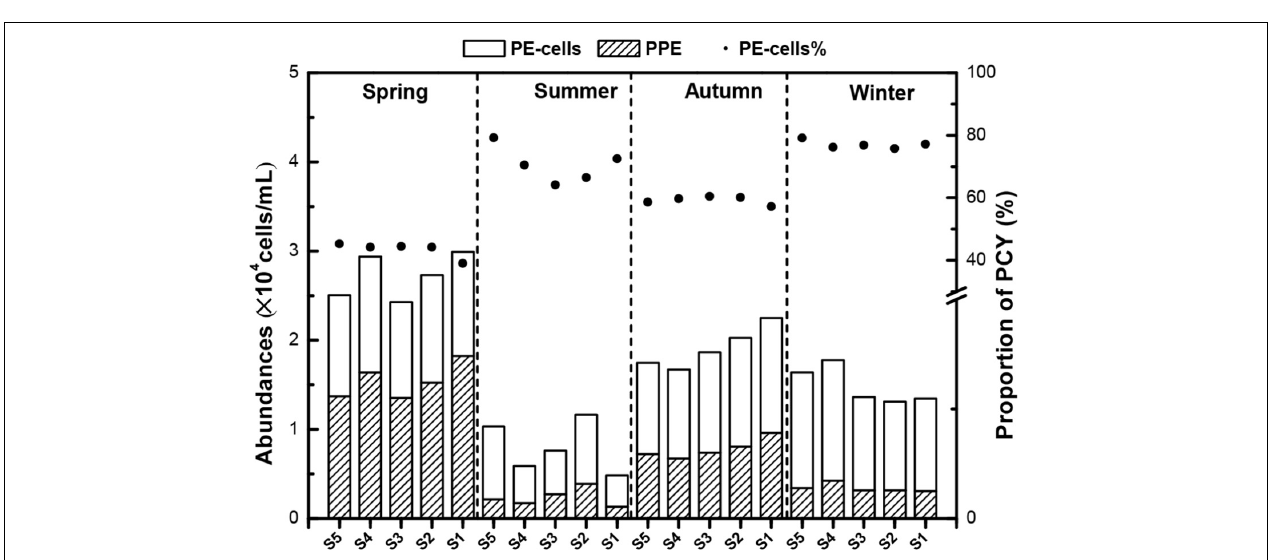
FIGURE 2 | (A) The size fractioned Chl- a concentrations (the columns) and the contribution of picophytoplankton to total phytoplankton Chl- a (the points) in Lake Fuxian. (B) The size fractioned net primary production (NPP, the columns) and the contribution of picophytoplankton to total phytoplankton primary production (the points) in Lake